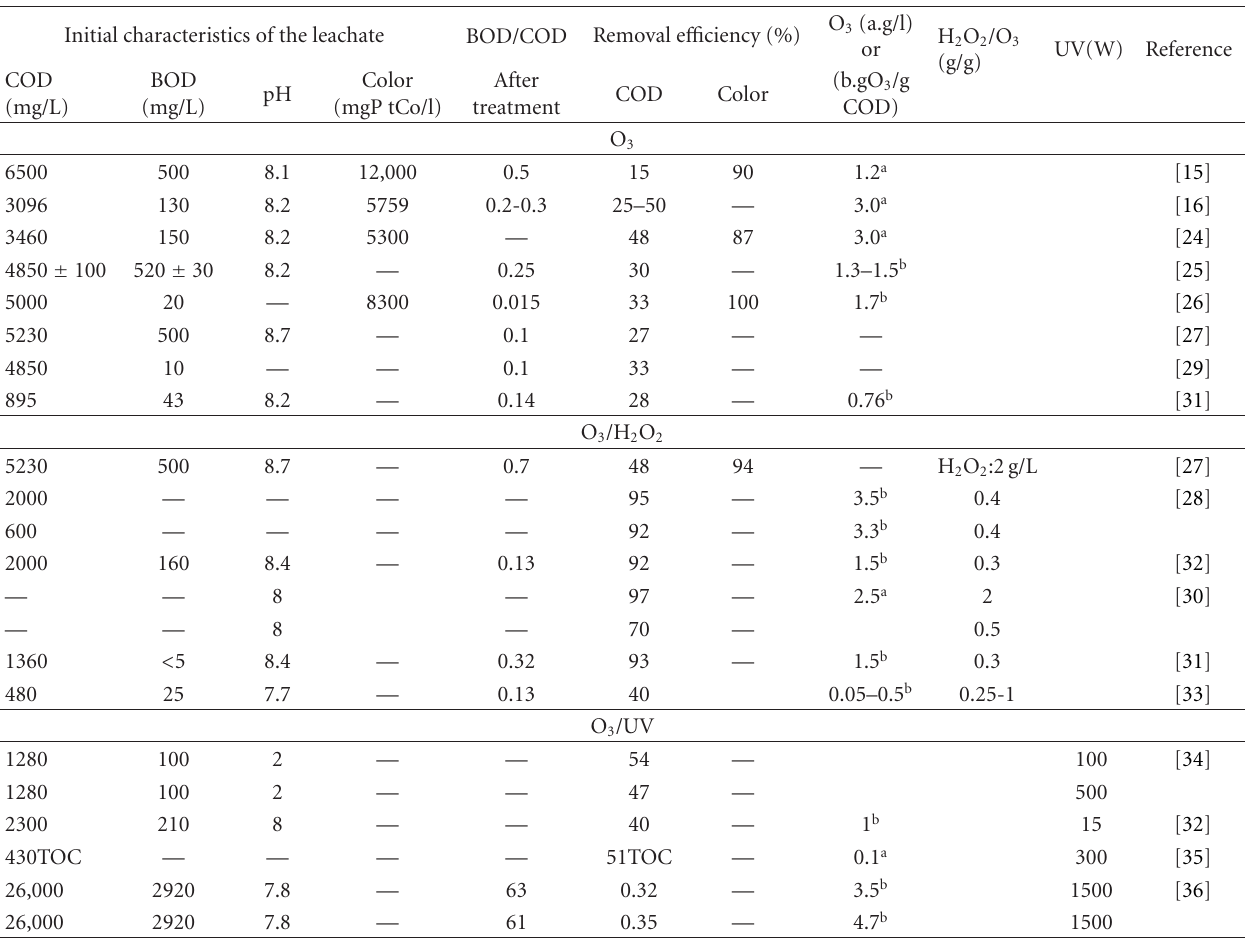
Table 3: O 3 , O 3 /H 2 O 2 , and O 3 /UV treatments of leachates (updated from Renou et al. [2]). Initial characteristics of the